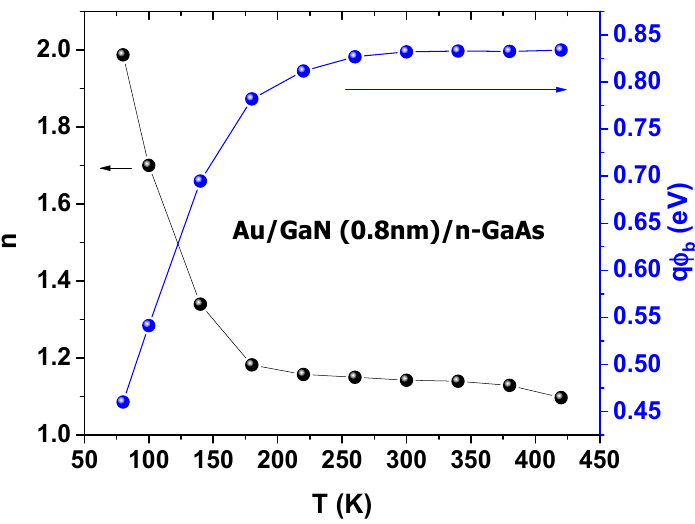
Figure 4. The n and φ b extracted at each temperature.